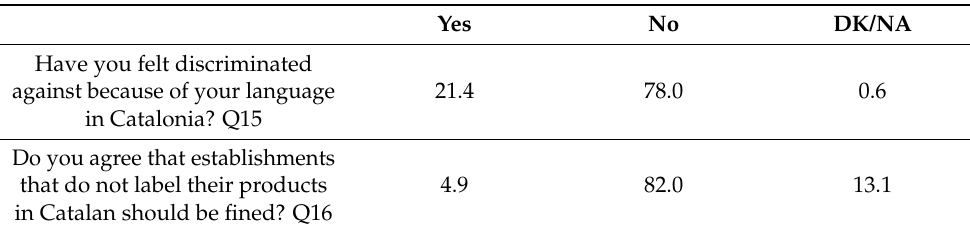
Table 2. Opinions on the current governance policies regarding language issues.